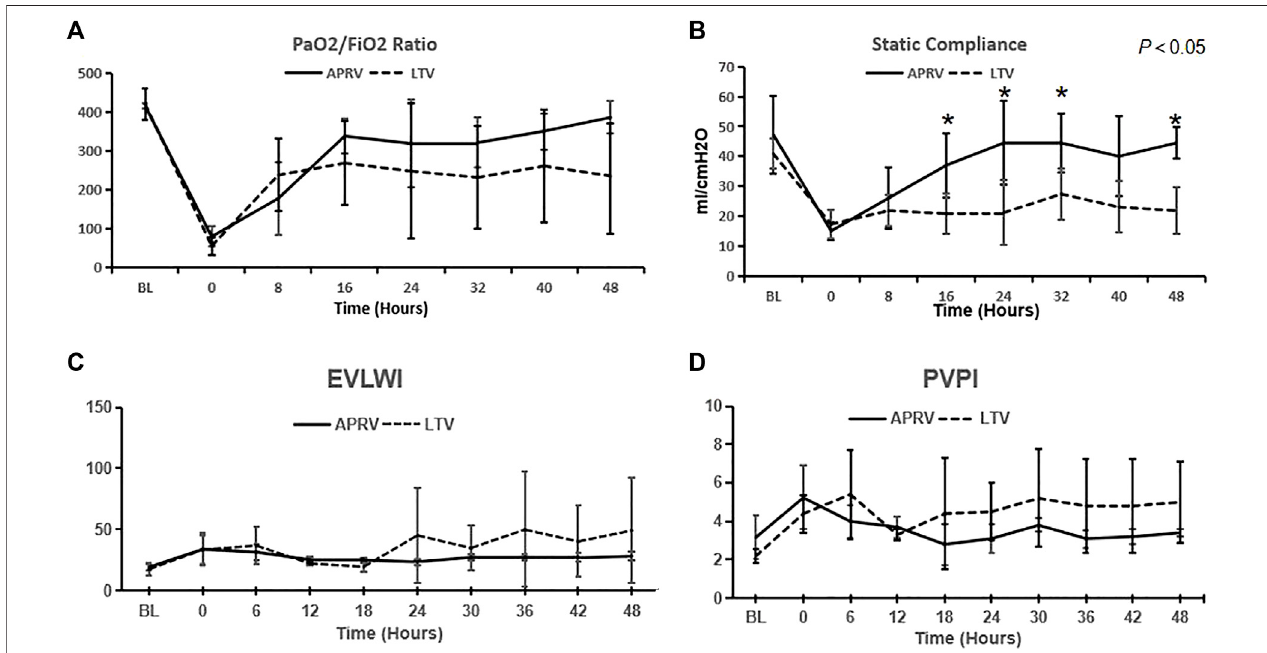
FIGURE 1 | Respiratory and hemodynamic parameters. The values of (A) PaO 2 /FiO 2 , (B) Cstat, (C) EVLWI, and (D) PVPI over time were calculated. The values were expressed as the mean ± SD. * p < 0.05. APRV, airway pressure release ventilation; LTV, low tidal volume ventilation; Cstat, respiratory system static compliance; EVLWI, extravascular lung water index; PVPI, pulmonary vascular permeability index.